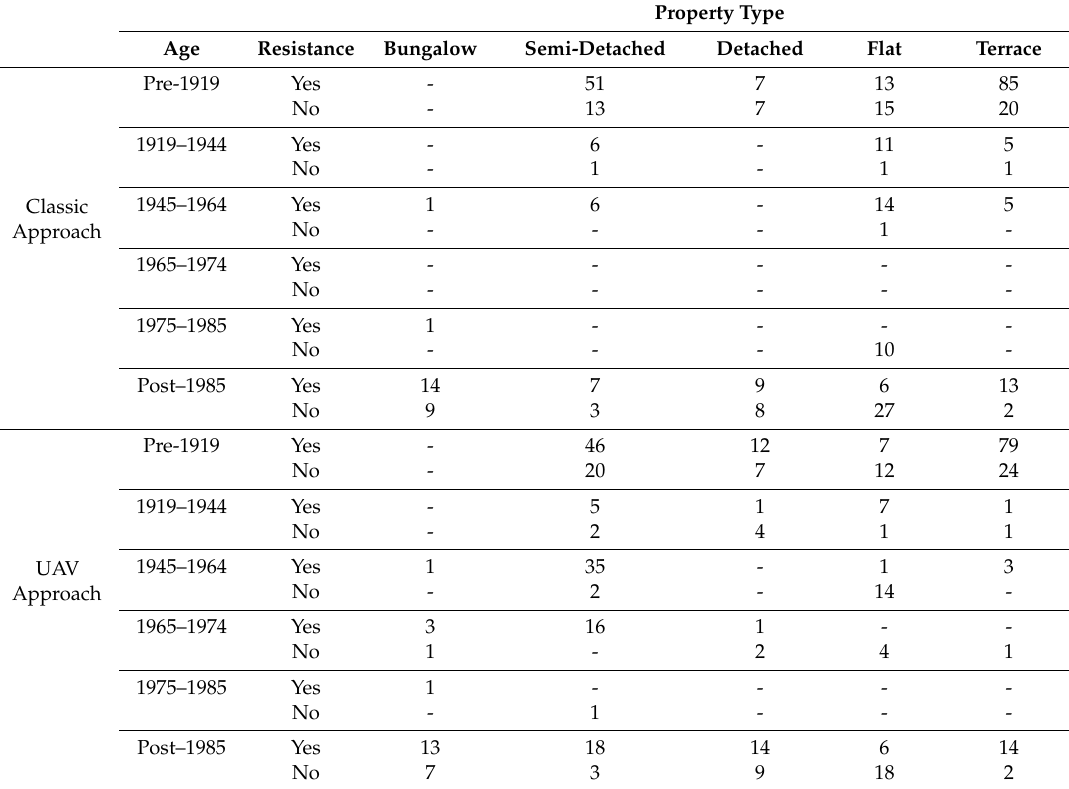
Table 3. Number of households with and without resistance measures identified as flooded in Cockermouth, Cumbria, UK, after Desmond (5–6 December 2015) based on the classic loss adjustment approach that relies on the Environment Agency fluvial flood extent and the unmanned aerial vehicle (UAV) loss adjustment approach. A total of 372 (classic) and 419 (UAV) residential properties were identified as flooded. The number of flats refers to those on the ground floor potentially affected by